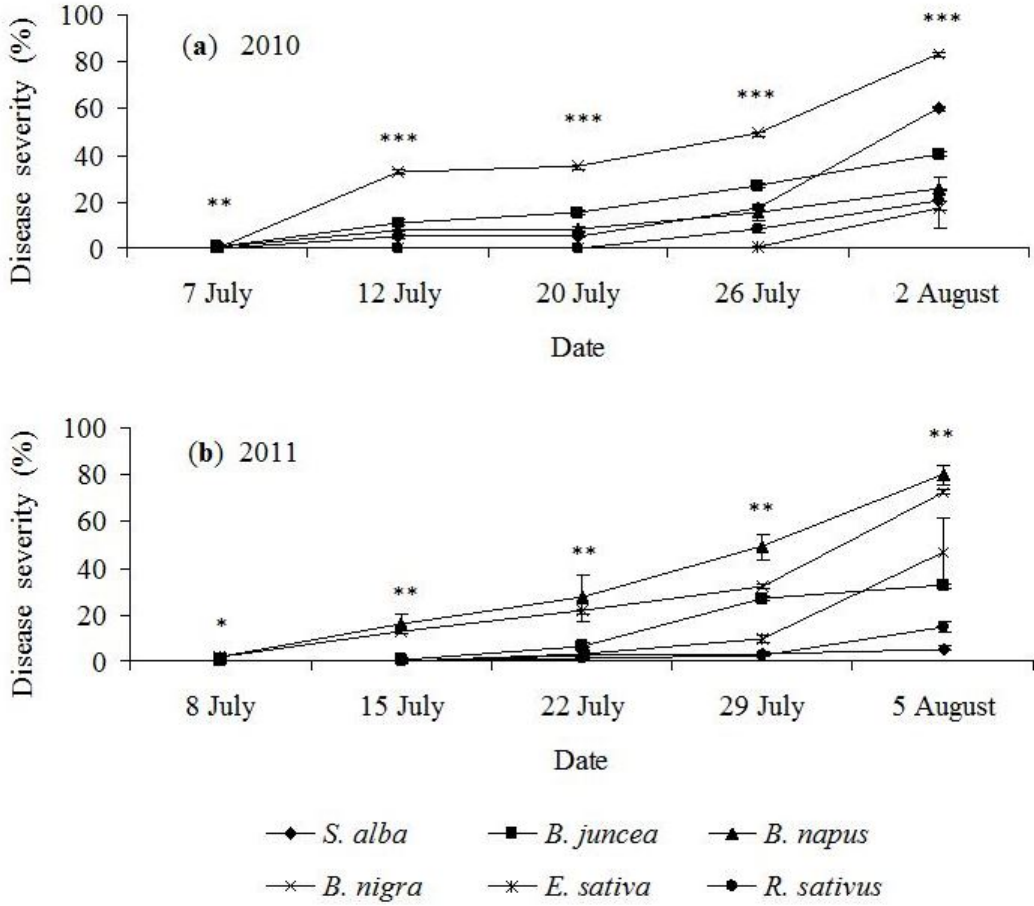
Figure 1. Development and Alternaria black spot ( A. brassicae ) severity (mean ± SE, %) on six different cruciferous oilseed crops in 2010 ( a ) and 2011 ( b ). The growing season of 2010 during the disease observations was hotter (22.2 °C for the period 1 July–10 August) than the growing season of 2011 (18.9 °C for the period 1 July–10 August). The asterisks demonstrate the significance of the species effect at p < 0.05 (*); p < 0.01 (**); and p < 0.001 (***).